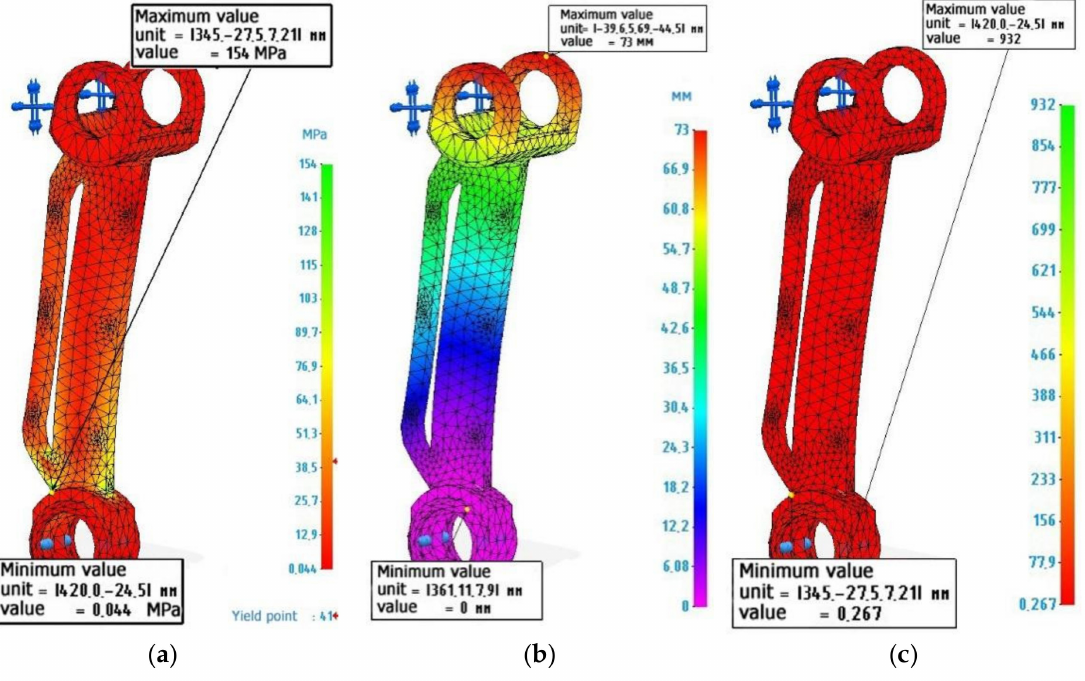
Figure 5. Finite element calculation of an exoskeleton lever made of ABS plastic: ( a ) Von Mises stress diagram, maximum value 154 MPa; ( b ) Strain diagram, maximum value 73 mm: ( c ) Safety factor diagram, minimum value